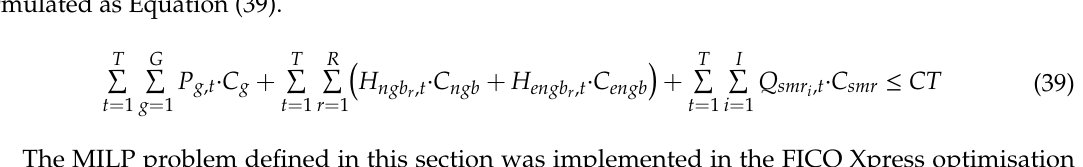
Table 2. Economic and operational parameters of the heating technologies. Heating technology